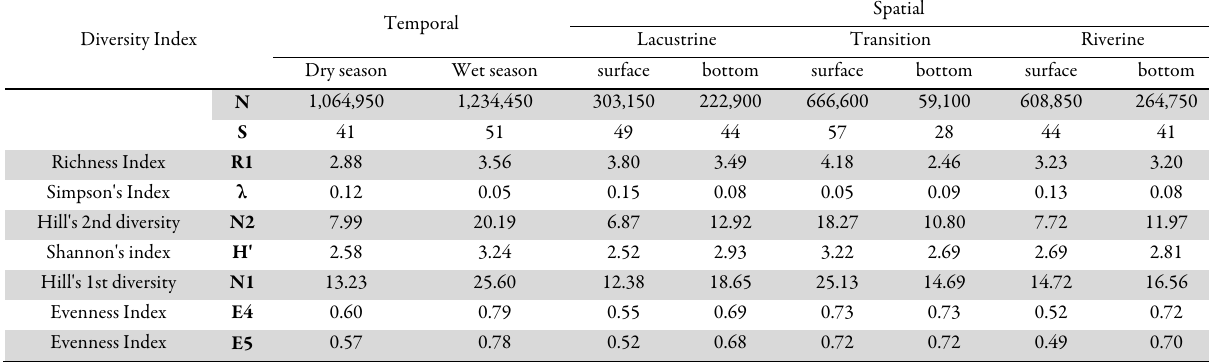
Table 6. Diversity indices for zooplankton at various sampling